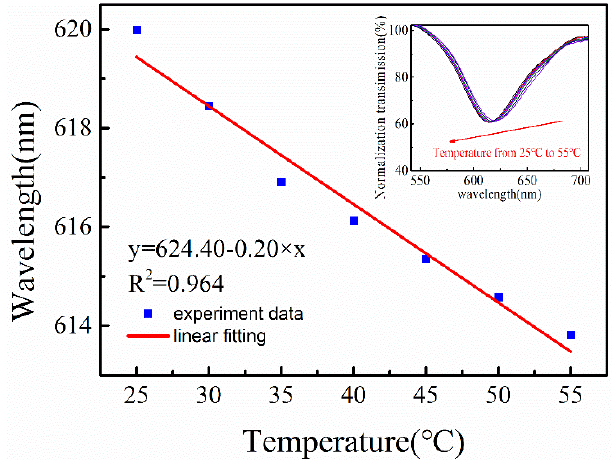
Figure 7. The resonance dip shift of the sensor with the initial wavelength at 619.99 nm when the temperature changes from 25 °C to 55 °C .